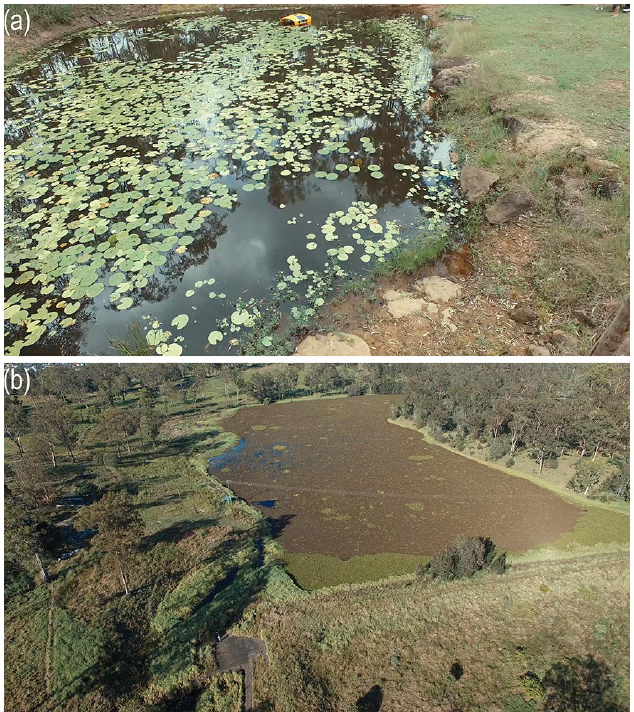
Figure A4. Oblique drone images showing natural obstacles for pond chamber deployments from (a) emergent macrophytes and (b) floating aquatic